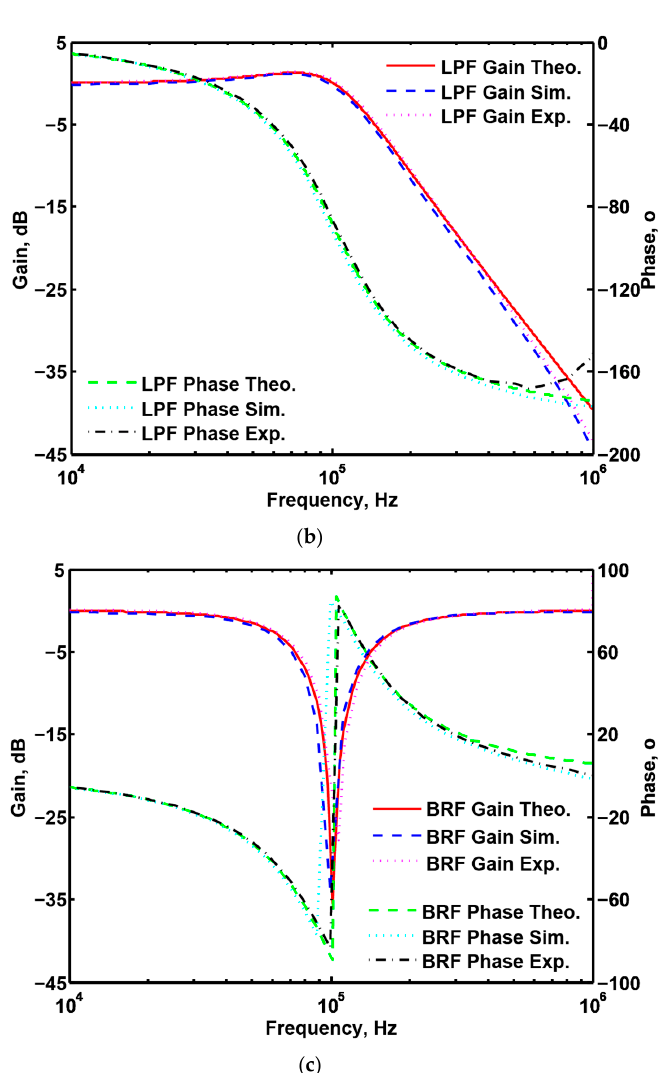
Figure 7. Simulated and experimental filter gain and phase responses with the theory responses. ( a ) The band-pass filter response; ( b ) the low-pass filter response; and ( c ) the band-reject filter response.